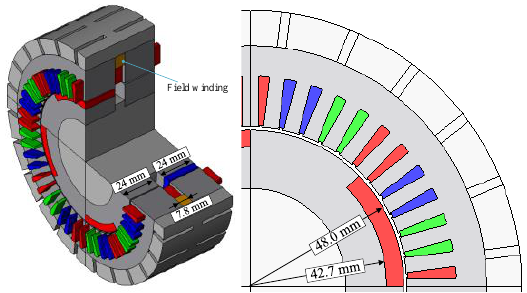
Figure 17. Analysis model of hybrid motor.